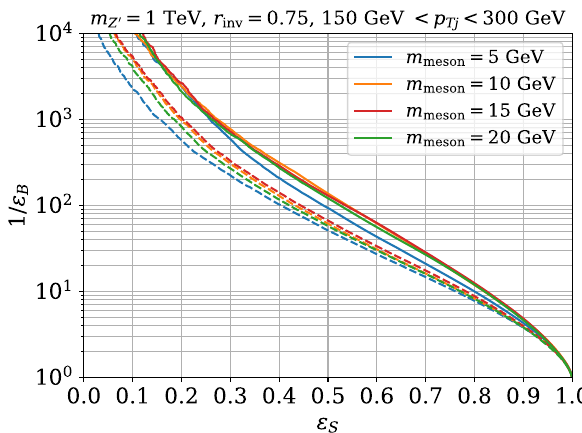
Fig. 51 Left: ROC curves showing the semi-visible jet tagging effi- ciency (cid:18) S andQCDbackgroundrejection1 /(cid:18) B foraDGCNNcompared to a CNN and a LoLa network operating on jet images and Lorentz vec- tors, respectively. Right: ROC curves for a DGCNN trained on a mixed